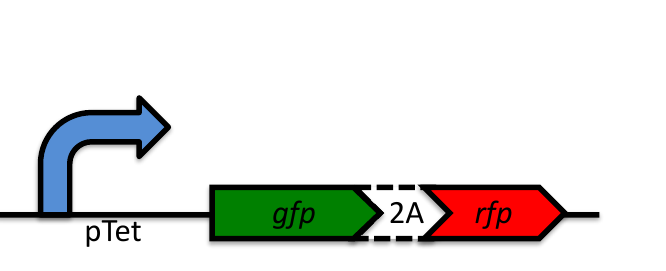
Figure 50: Bicistronic expression of both GFP and RFP from a signal coding sequence, by means of a 2A self-cleaving polypeptide